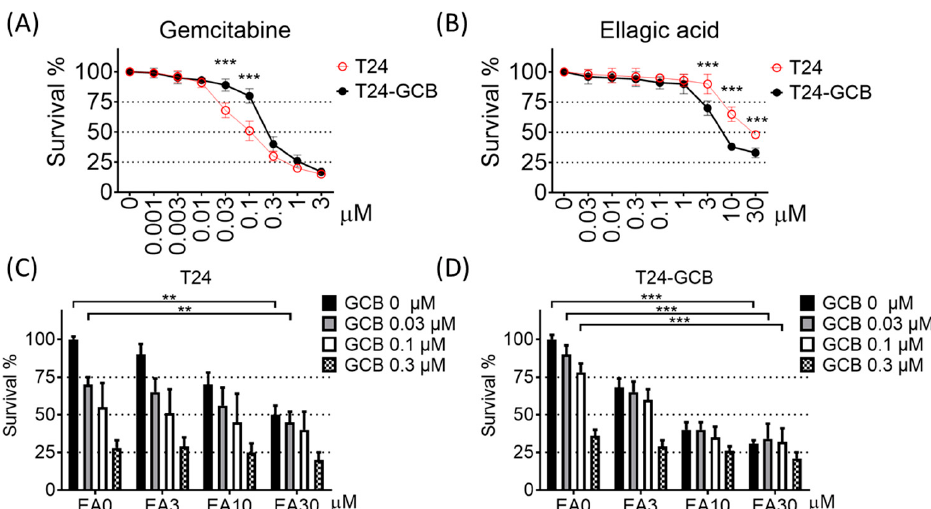
Figure 1. Cytotoxicity was measured with the MTT assay after 48 h of treatment in T24 cells or gemcitabine-resistant T24 cells (T24-GCB) with serial concentrations of ( A ) gemcitabine (GCB) and ( B ) ellagic acid (EA). The cytotoxicity of the combined treatment of EA and GCB was also evaluated in ( C ) T24 and ( D ) T24-GCB cells. ** < 0.01 and *** < 0.001.